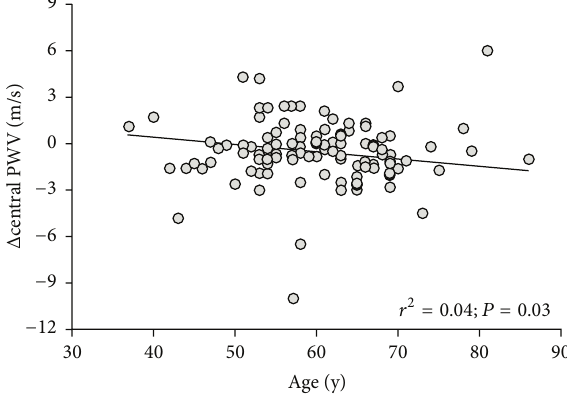
Figure 2: Relationship between changes (Post-Pre) in central pulse wave velocity (PWV) and age in simvastatin-treated participants ( 𝑛 = 110 ). Δ = absolute change from before to after the treatment